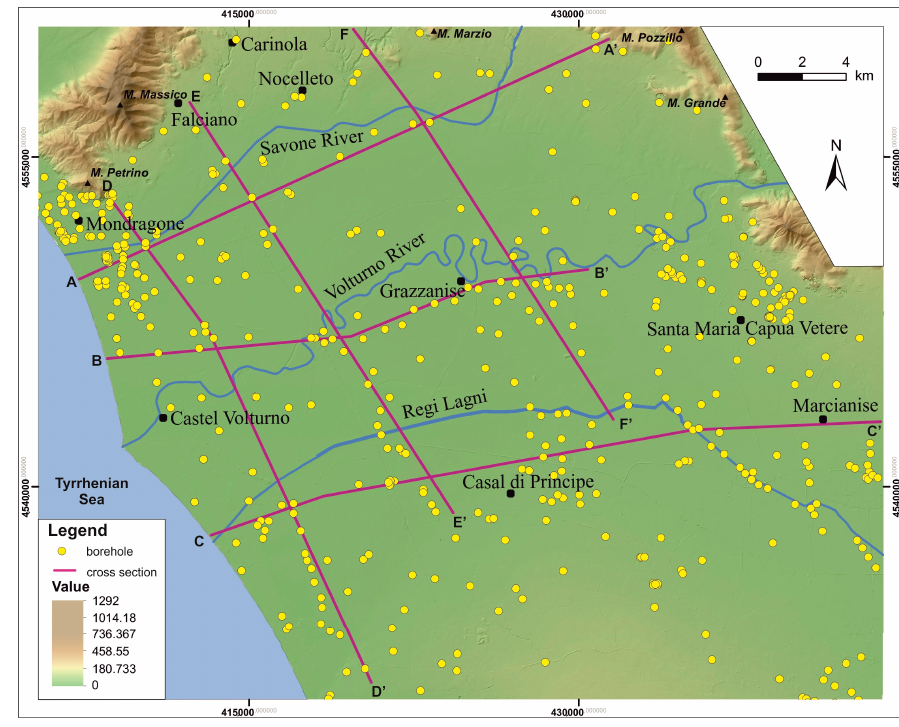
Figure 2. Locations of boreholes and geological